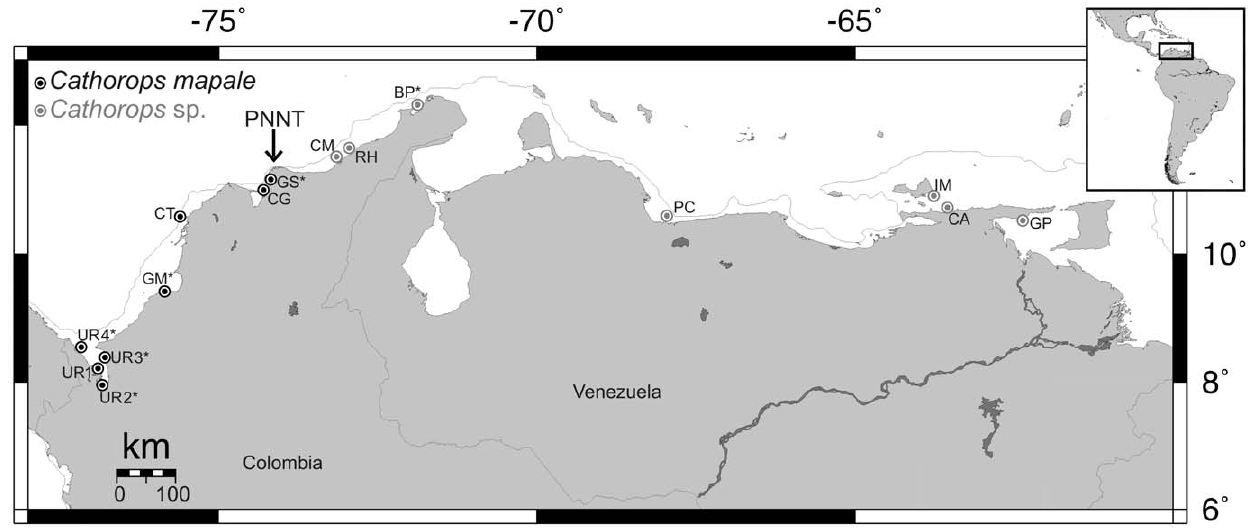
Figure 1. Sampling localities for the Cathoropsmapale group along the southern Caribbean. Arrow indicates Parque Nacional Natural Tayrona (PNNT), where the continental shelf is narrower (gray line shows 200 m isobath). UR, Uraba´; GM*, Golfo de Morrosquillo; CT, Cartagena; CG, Cie´naga Grande de Santa Marta; GS, Golfo de Salamanca; CM, Camarones; RH, Riohacha; BP*, Bahı´a Portete; PC, Puerto Cabello; IM, Isla Margarita; CA, Carupano; GP, Golfo de Paria (map from www.aquarius.ifm-geomar.de). *Only morphological material examined from these localities.